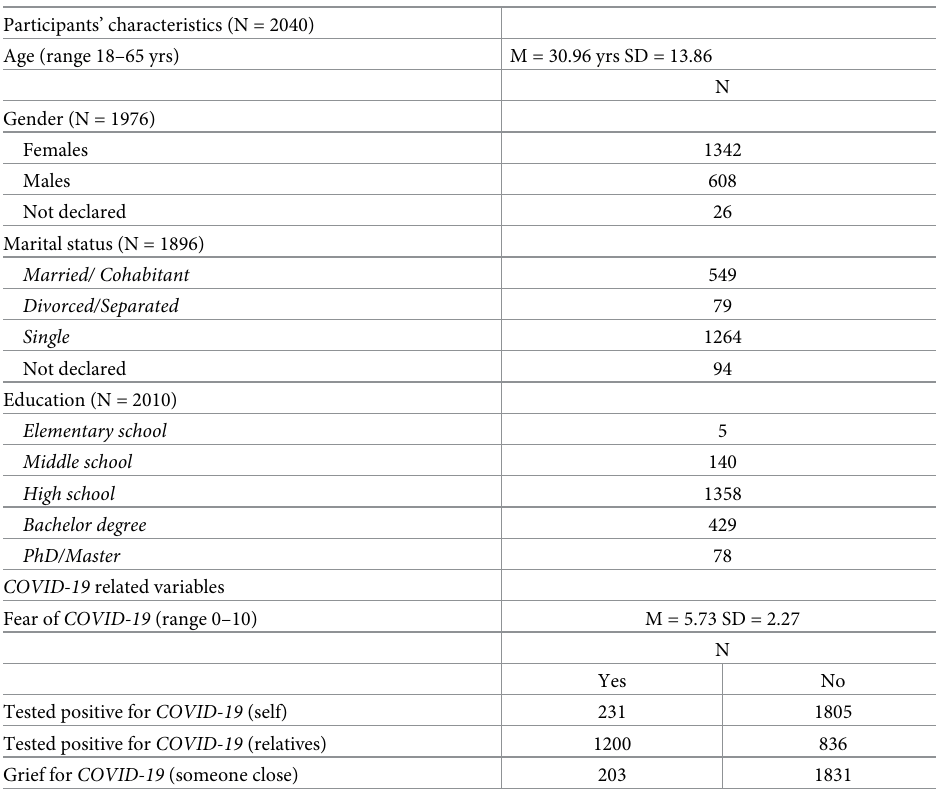
Table 1. Descriptive statistics and COVID-19 related variables. Participants’ characteristics (N =